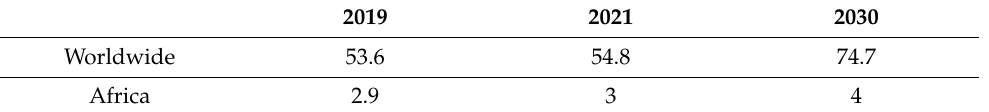
Table 4. In 2019, the world generated millions of tons of e-waste. Comparative values for Africa are reported as estimated values for 2021 und predicted values for 2030